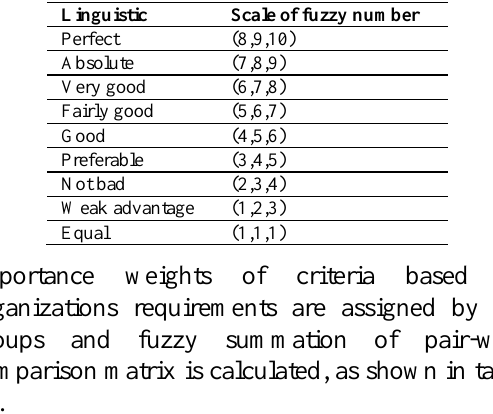
Table 9. Membership function of linguistic scale.